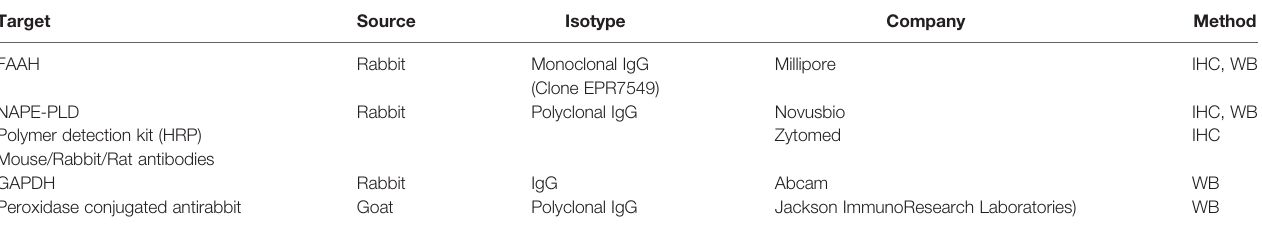
TABLE 2 | Antibody